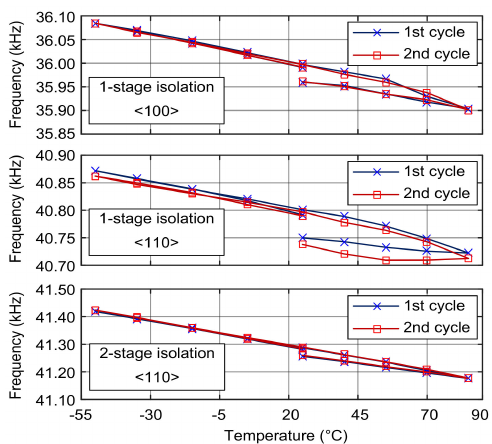
Figure 10. Natural frequency of the stress-isolated